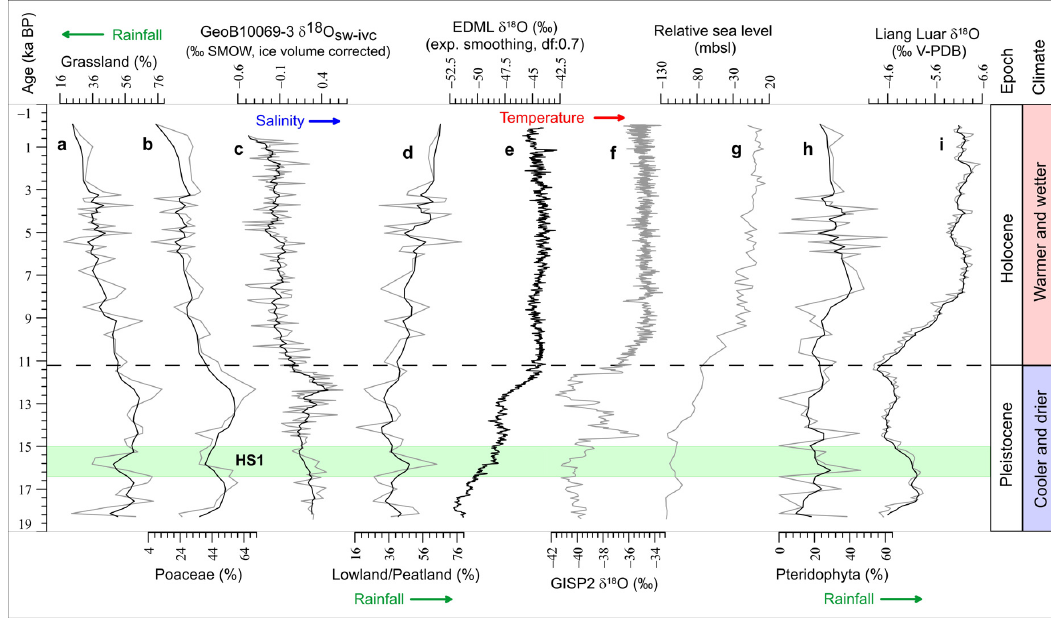
Figure 8. Last Deglaciation–Holocene climate inferred from palynological (pollen and spores) proxies ( a , b , d , h ) and other paleoclimate records used for comparison: ( c ). δ 18 O seawater with ice volume correction ( δ 18 Osw-ivc) record of GeoB10069-3 [72], ( e ). δ 18 O record of Antarctic (EDML) ice core [81], ( f ). δ 18 O record of Greenland (GISP2) ice core [82], ( g ). Reconstructed relative sea level from δ 18 O of Red sea benthic foraminifera [83–85], ( i ). δ 18 O record of stalagmites from Liang Luar cave (Flores) [16]. Data are plotted against the mean ages obtained from the age model. Black curves indicate smoothed values (exponential smoothing, df: damping factor) (Table S5).